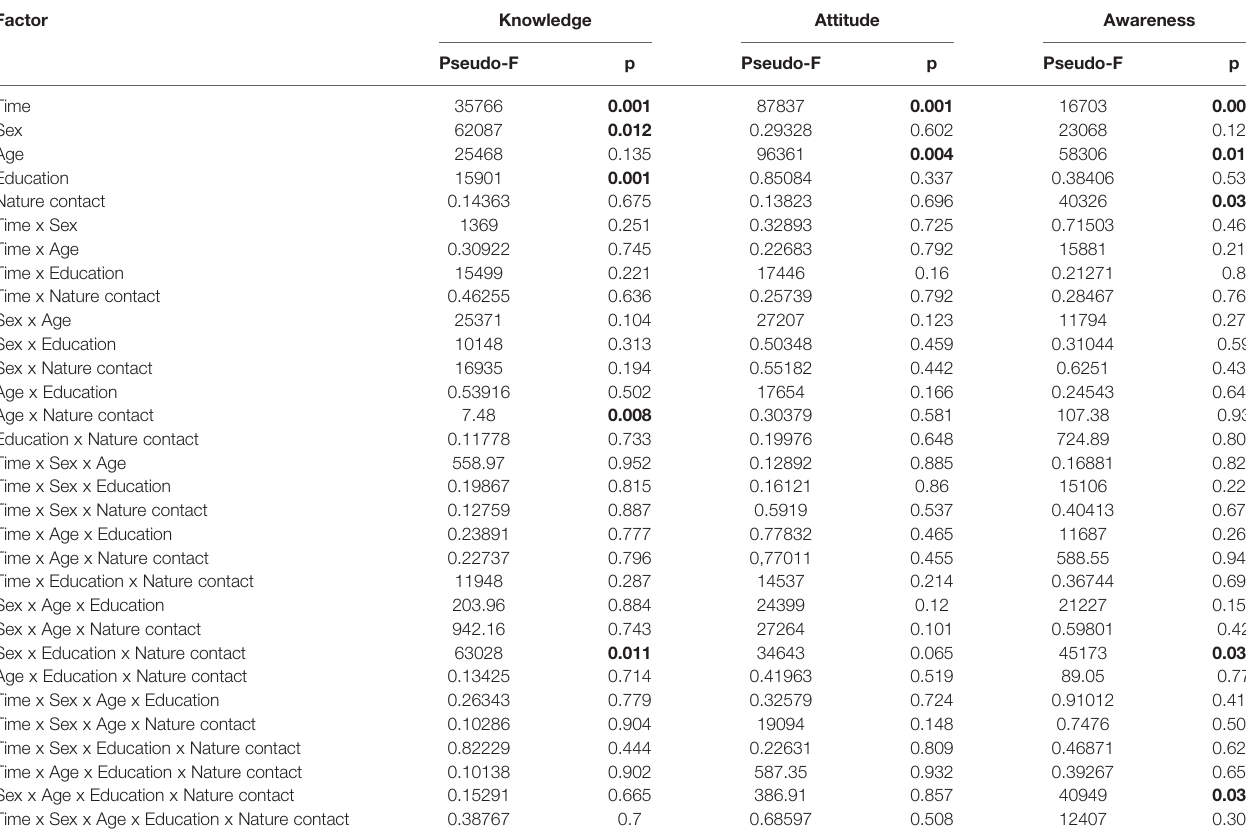
TABLE 5 | PERMANOVA a,b test for demographic factors and factor